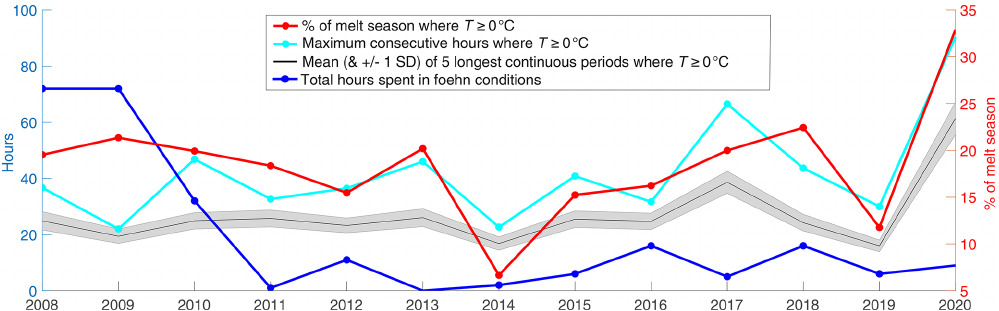
Figure 6. Analysis of sustained warm ( ≥ 0 ◦ C) air temperature ( T ) periods and foehn wind occurrence for the 2007/2008 to 2019/2020 melt seasons. The cyan line shows the maximum number of consecutive hours in each melt season when T ≥ 0 ◦ C. The black line shows the mean length (hours) of the five longest periods when T ≥ 0 ◦ C for each season, with the grey shading indicating ± 1 standard deviation from that mean. The red line shows the proportion of each season (1 November to 31 March) when T is ≥ 0 ◦ C. The blue line shows the total number of hours spent in a foehn condition (see Sect. 3.4 for definition) each season. The x axis dates indicate the second year of each austral summer, e.g. 2020 corresponds to the 2019/2020 season.